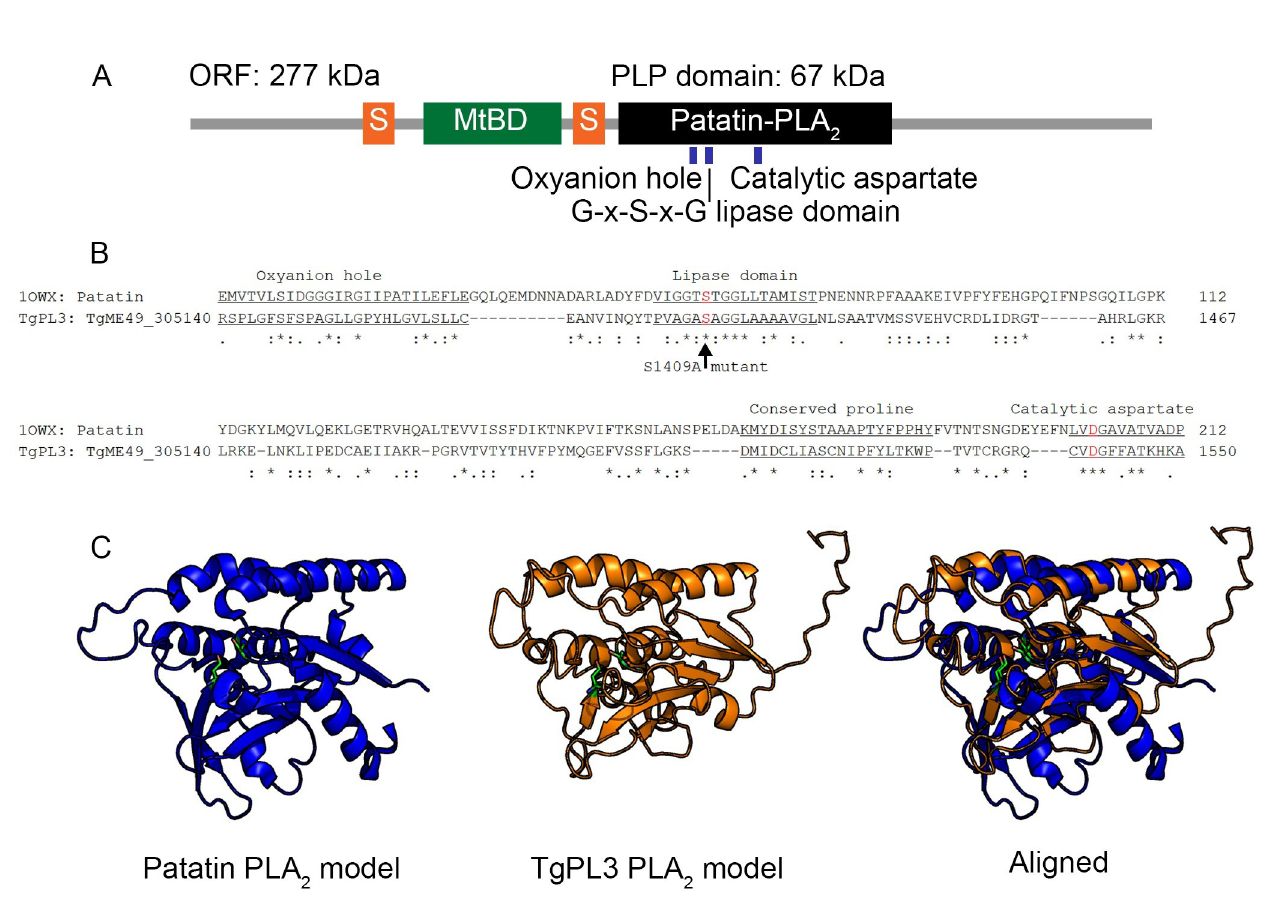
Fig 1. Predicted domains of TgPL3 based on sequence and structural alignments. (A) In orange, two serine-rich domains (S) flank the microtubule binding domain (MtBD) in green. The first serine-rich domain contains 34 consecutive serines and the second contains 37 serines interrupted by 2 prolines and 2 alanines. The putative PLP domain is shown in black. (B) The PLP domain contains all the necessary conserved amino acids for activity based on sequence alignment. The known conserved patatin motifs are underlined and catalytic S/A dyad are colored red. The serine to alanine mutation (S1409A) is indicated by an arrow. (C) Structural alignment of the TgPL3 PLP domain (orange) to the patatin PLA 2 crystal structure (blue) predicts correct folding to form the active site. The secondary and tertiary structures of the TgPL3 PLP domain were predicted using I-TASSER and the resulting model was aligned to the PDB model of patatin (1OWX) in PyMOL. The catalytic serine and aspartate dyad are shown in green in each model.